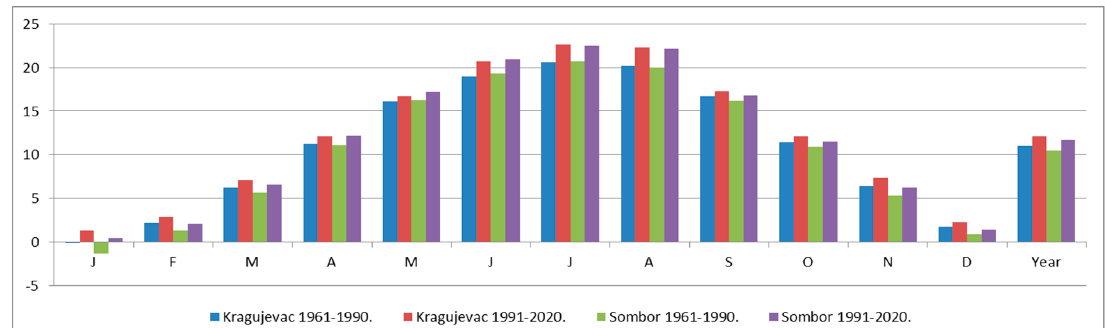
Figure 2. Average monthly temperatures per month and year for the period 1961–1990 and 1991–2020 in Kragujevac and Sombor.